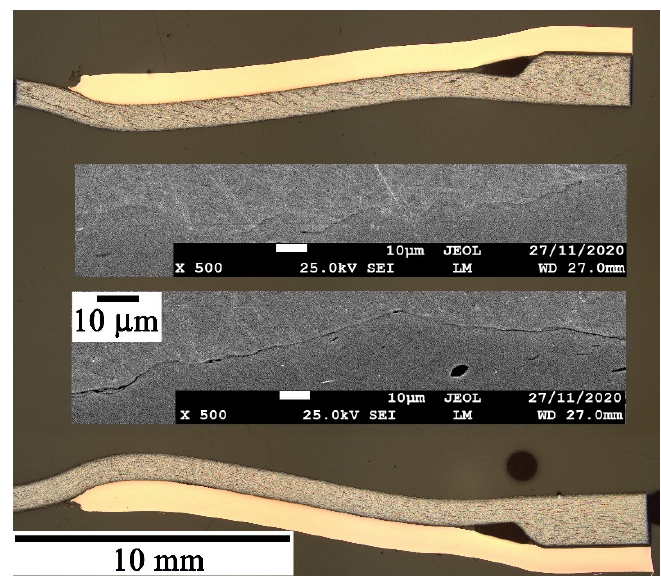
Figure 6. Macroscopic view of the longitudinal joint cross-section with SEM backscattered images at two random locations along the welded length, showing a slightly wavy interface profile for a weld made with a polyurethane internal support. Conditions for this welded sample: discharge energy = 14 kJ, stando ff distance = 1 mm, flyer tube diameter and wall thickness = 22.22 and 0.89 mm, target tube diameter and wall thickness = 18.44 and 1